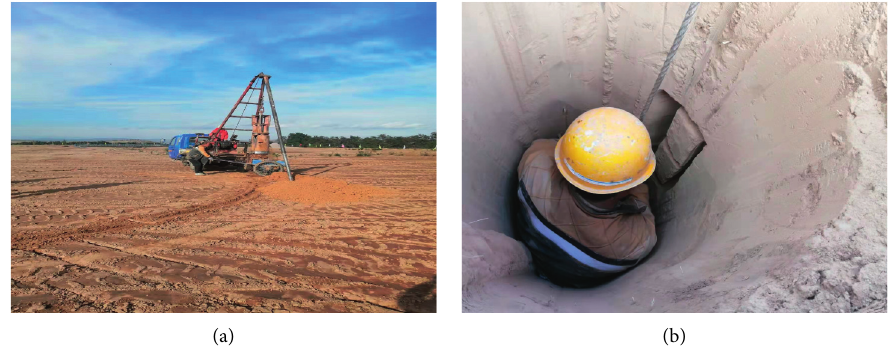
Figure 1: Sampling process of soil sample. (a) Borrow site. (b) Sampling location.